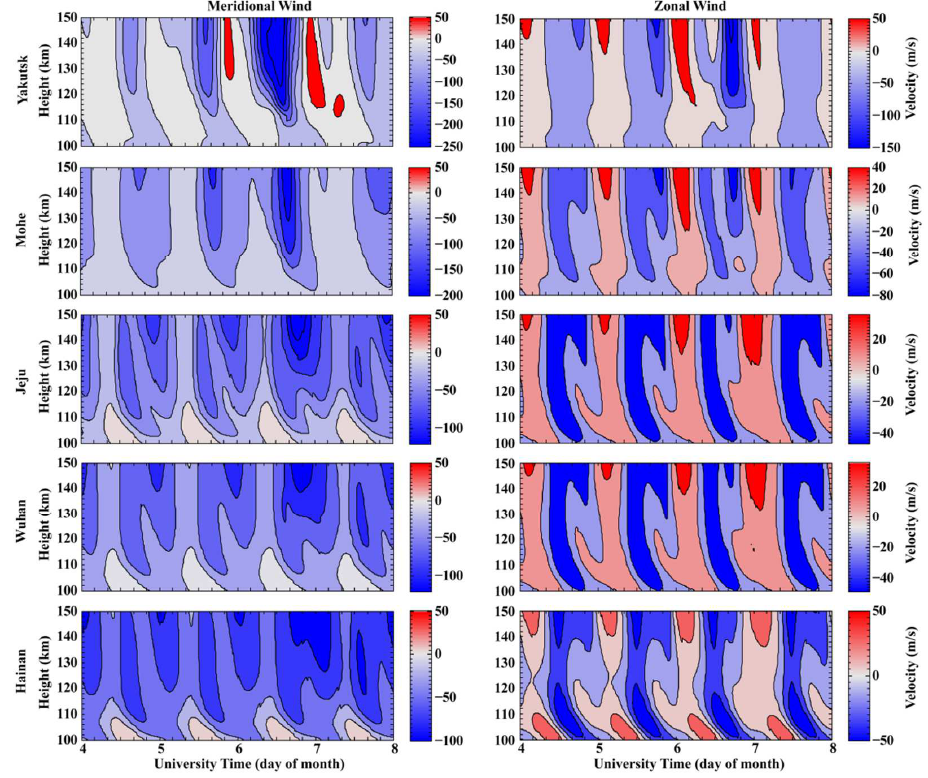
Figure 6. Simulation of wind using TIE−GCM model at the height from 100 to 150 km. The left row is for meridional wind, and the right row is for zonal wind.